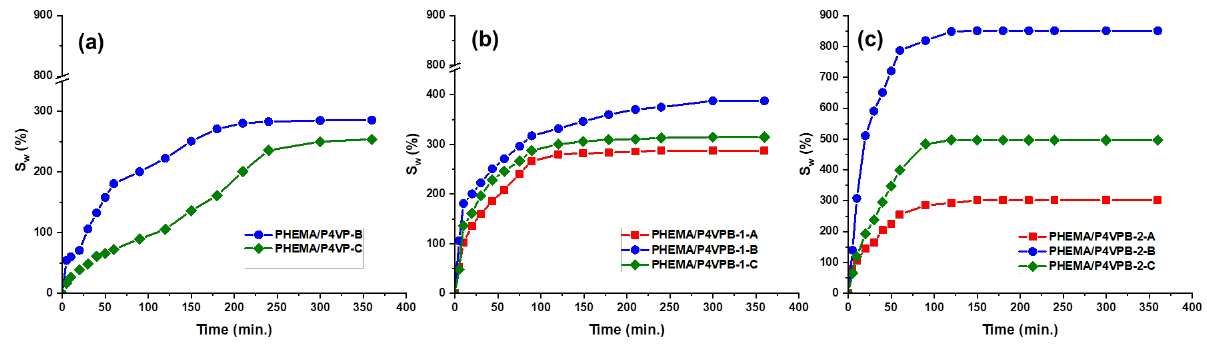
Figure 7. The influence of the solvents of linear polymers on the degree of swelling in water of PHEMA/P4VP ( a ), PHEMA/P4VP-1 ( b ) and PHEMA/P4VP-2 ( c ): A-NaHCO 3 (0.25N); B-CH 3 OH:NaHCO 3 (40:60, v / v ); and C-C 2 H 5 OH:NaHCO 3 (40:60, v / v ).